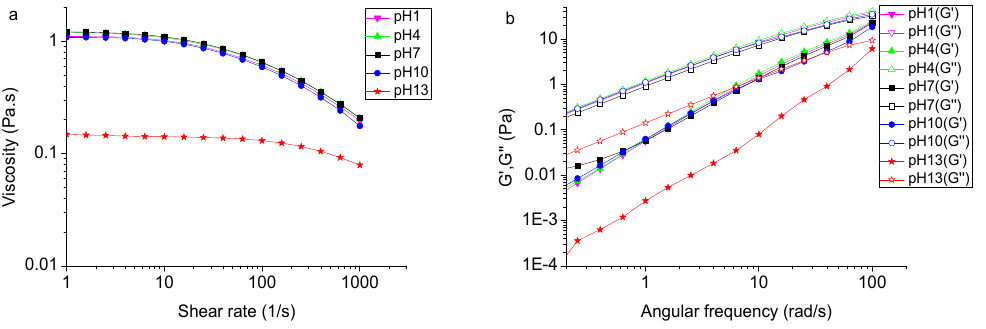
Figure 5. ( a ) Effect of pH on the apparent viscosity of TSP at the concentration of 2% ( w / v ) at 25 °C; ( b ) Effect of pH on dynamic modulus of TSP at the concentration of 2% ( w / v ) at 25 °C.